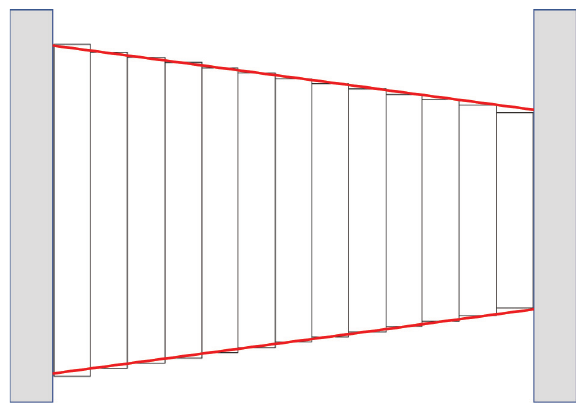
Figure 3: Clamped-clamped tapered beams with a taper ratio equal to 0.2.